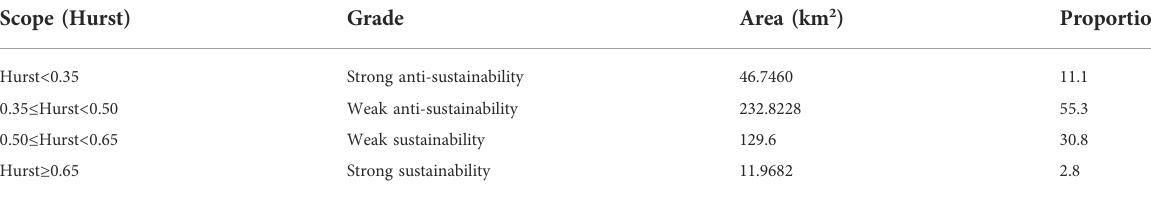
TABLE 4 Sustainability associated with changes in vegetation coverage in the upper reaches of ganjiang river basin during 2000 – 2020.